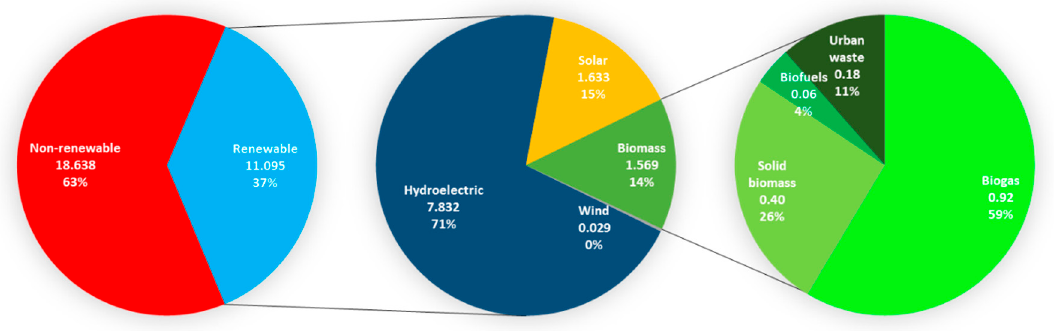
Figure 7. Provenience of the electrical energy generated in Piedmont in 2018 (in TWh).